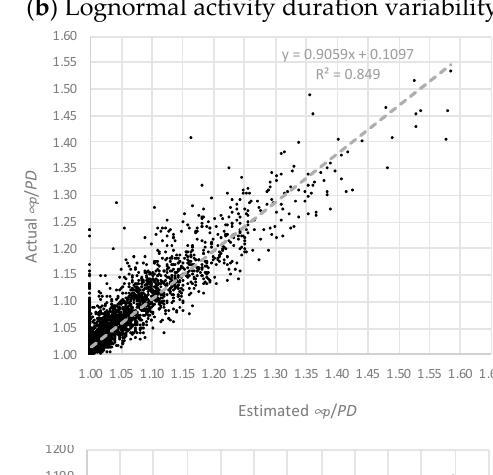
Figure 3. Dataset I σ p regressions with normal ( a ) and lognormal ( b ) activity duration variability.